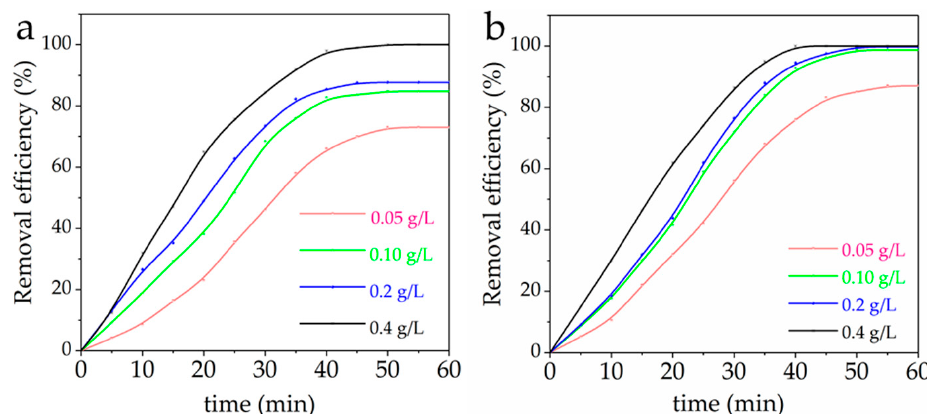
Figure 8. Simultaneously removing ( a ) Cr(VI) and ( b ) aniline at various MFH dosages. ( c 0 (Cr(VI)) = 40.0 mg·L − 1 , c 0 (aniline) = 100.0 mg·L − 1 , pH = 3.0, T = 25 °C).